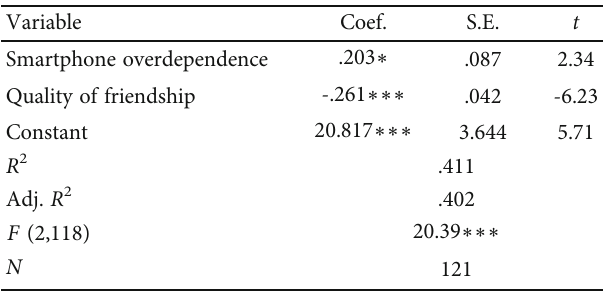
Table 6: Results of the multiple regression analysis with RDWLS among the